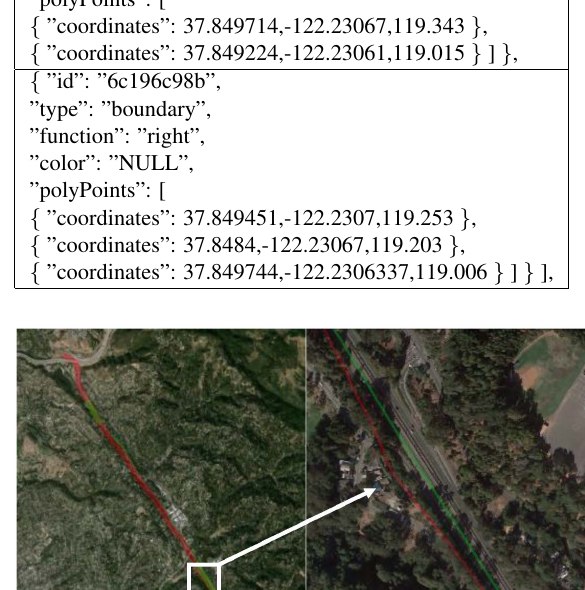
using our proposed approach. These positions are subtracted from the ground truth and the position error is calculated in every epoch. The results are shown in Figure 6. The measured GPS position error is shown in red and the estimated position error in our proposed approach is shown in blue.